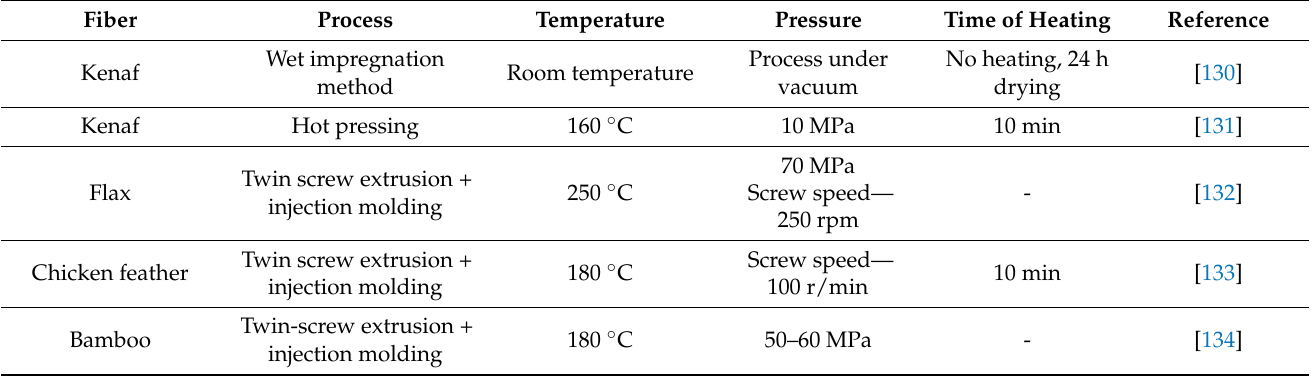
Table 6. Fabrication methods and processing parameters for PLA-based green